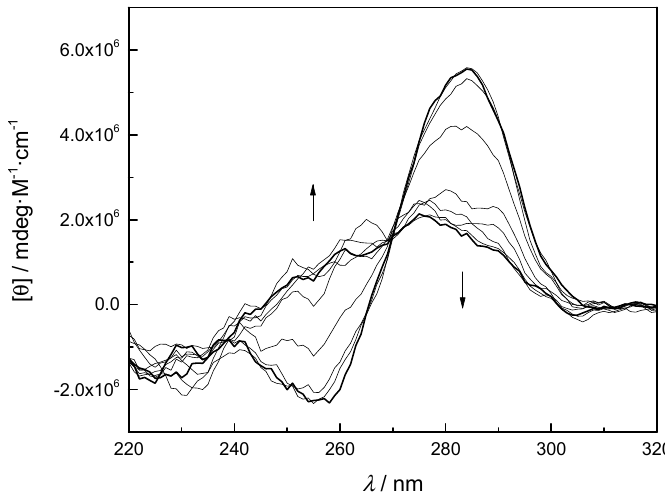
Figure 4. CD (circular dichroism) spectra of ON1b-Pd • ON5a , recorded at 10 ◦ C intervals between 10 and 90 ◦ C; pH = 7.4 (20 mM cacodylate buffer); [oligonucleotides] = 3.0 µ M; I (NaClO 4 ) = 0.10 M. Spectra acquired at extreme temperatures are indicated by thicker lines and thermal shifts of the minima and maxima by arrows.